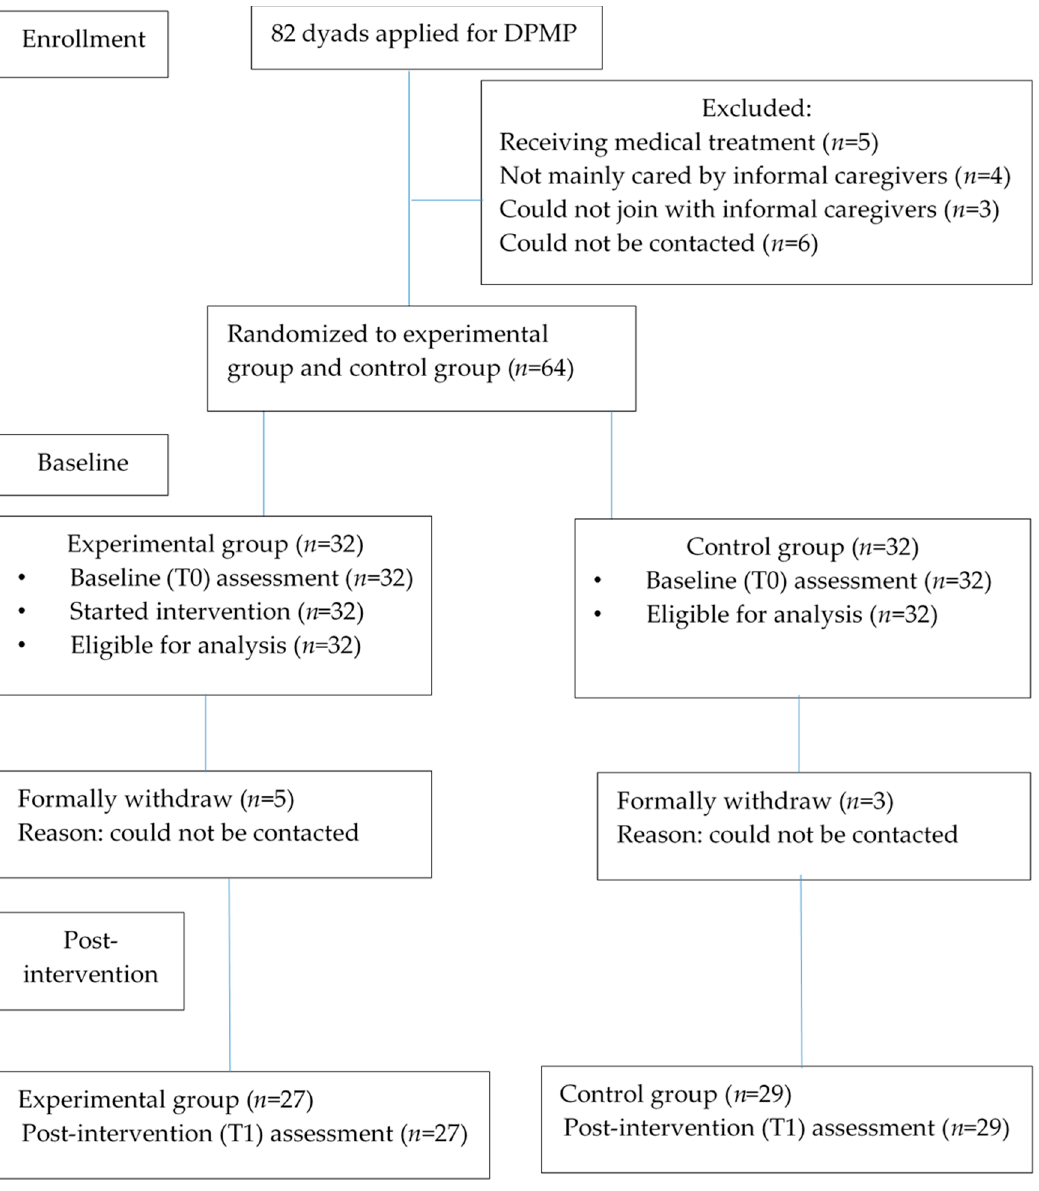
Figure 1. The flow of this study.